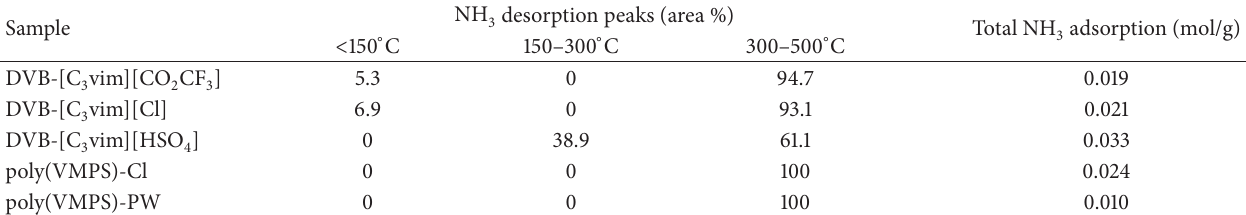
Table 1: Acid properties of the different carboxylic acids modified Zr-Mo oxides catalysts a .